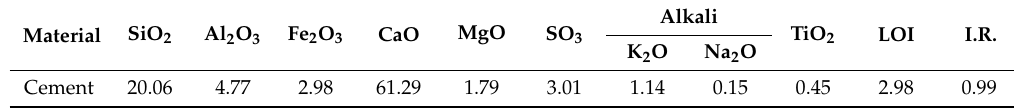
Table 2. Cement chemical composition